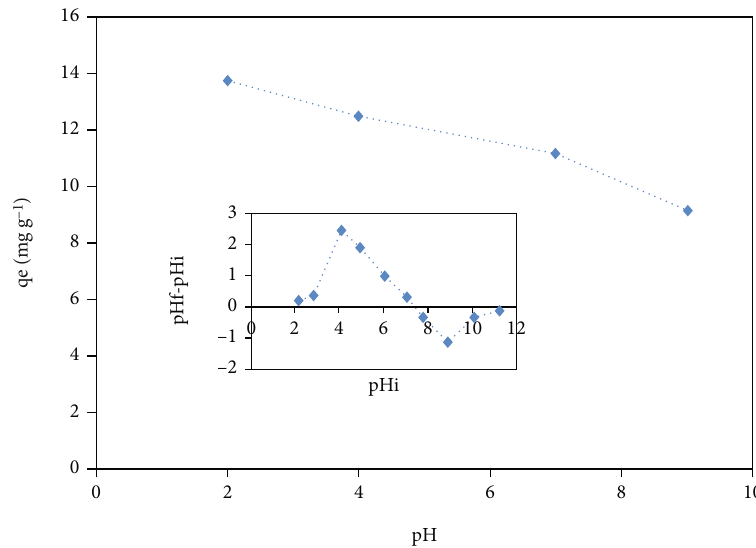
Figure 6: E ff ect of the initial pH of the carmoisine solution on adsorption e ffi